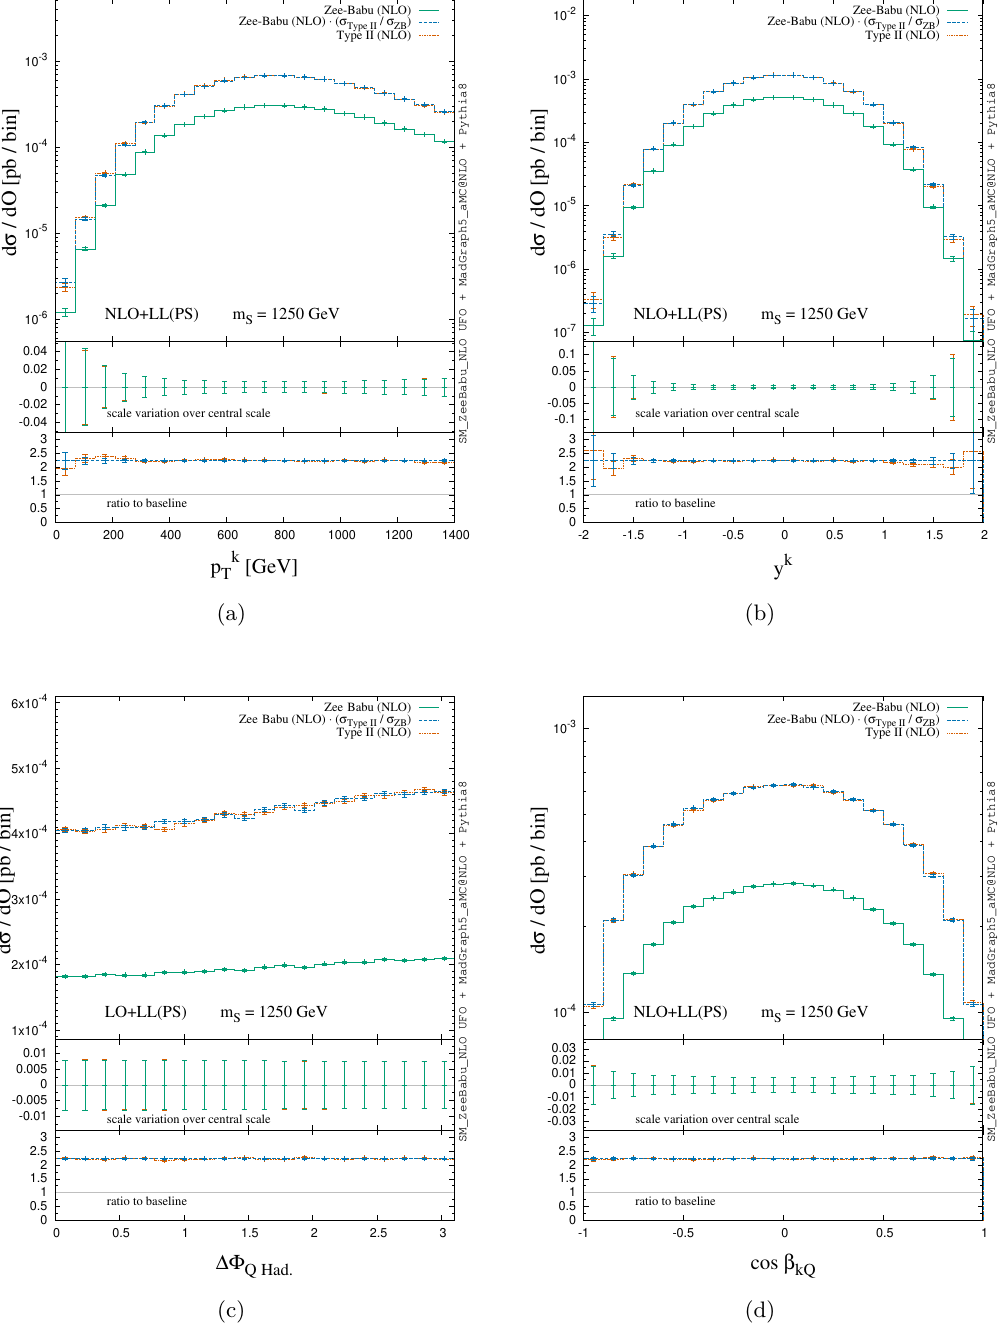
Figure 7 . Same as figure 6 but for m S = 1250 GeV